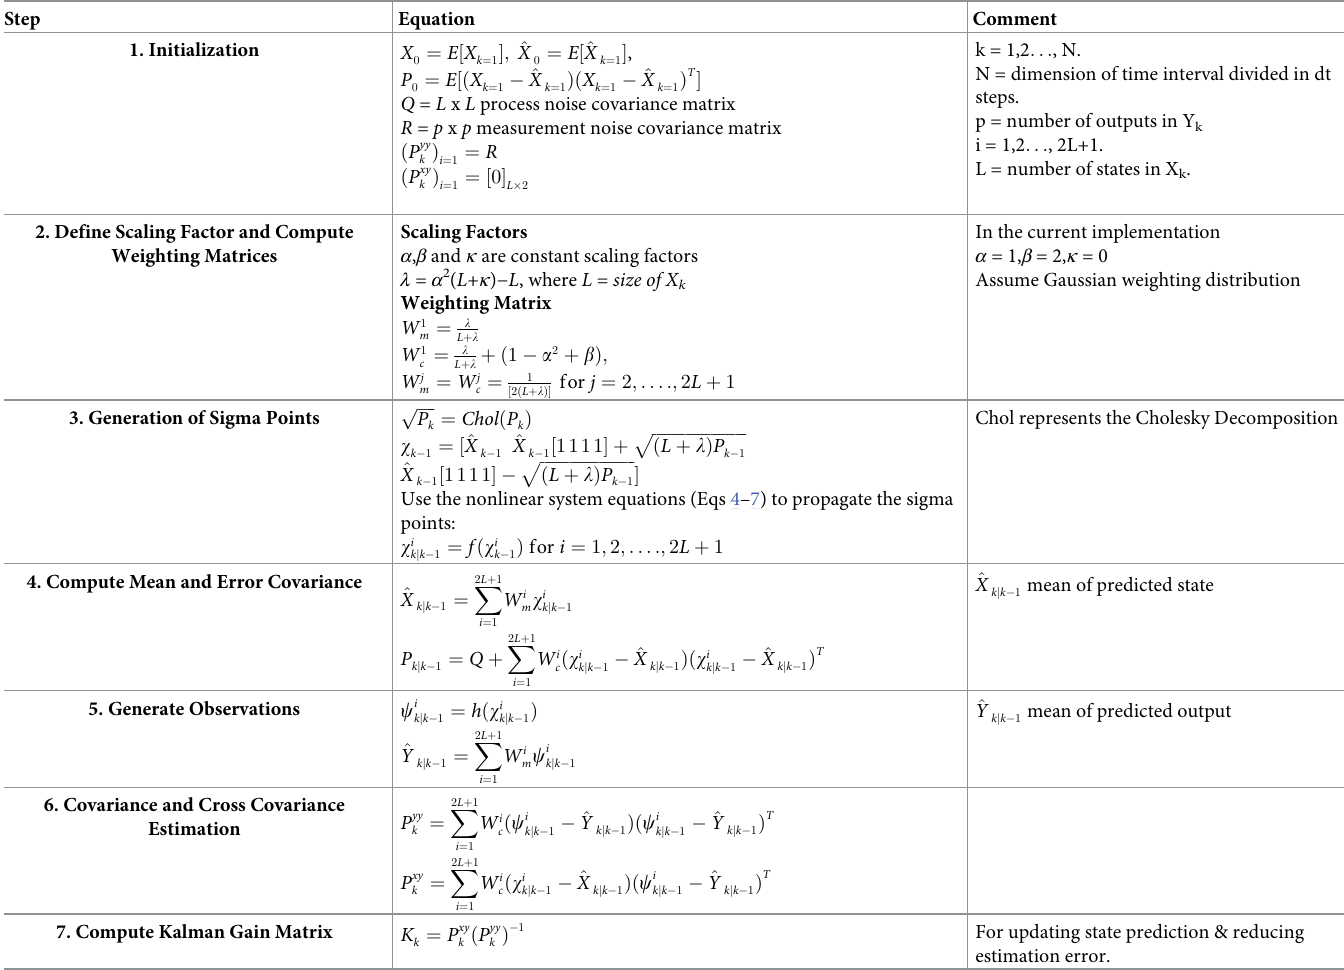
Table 1. Unscented Kalman Filter estimation